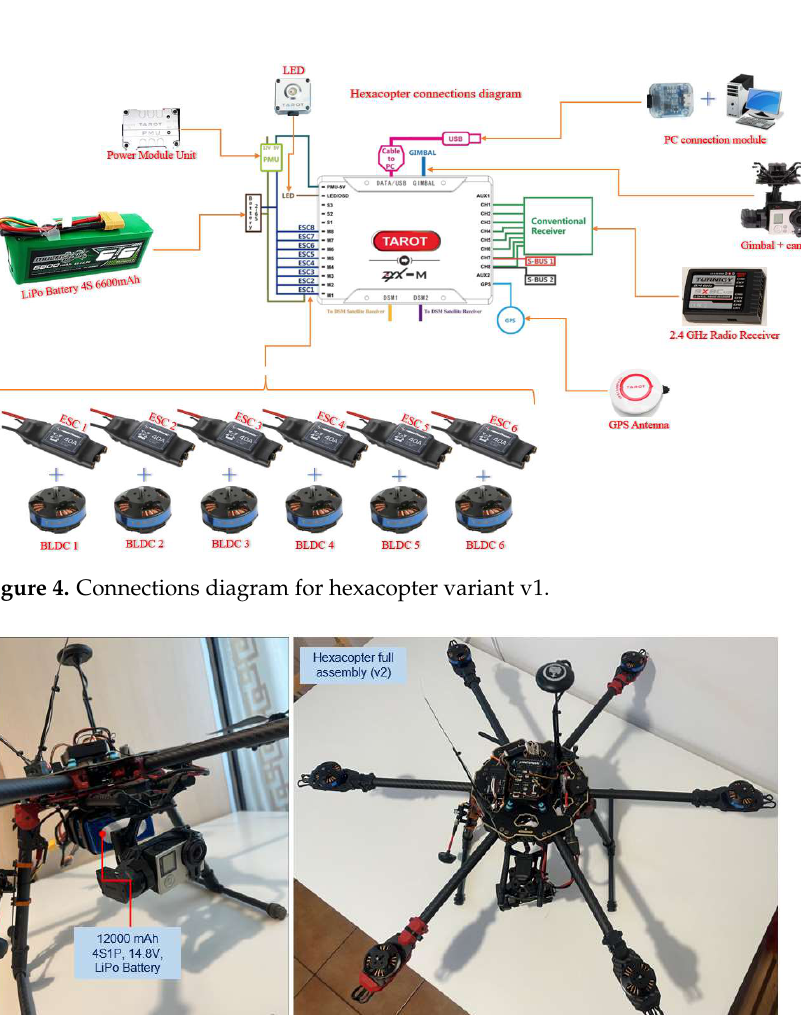
Figure 3. Hexacopter variant v1. ( a ) Components; ( b ) Assembly.